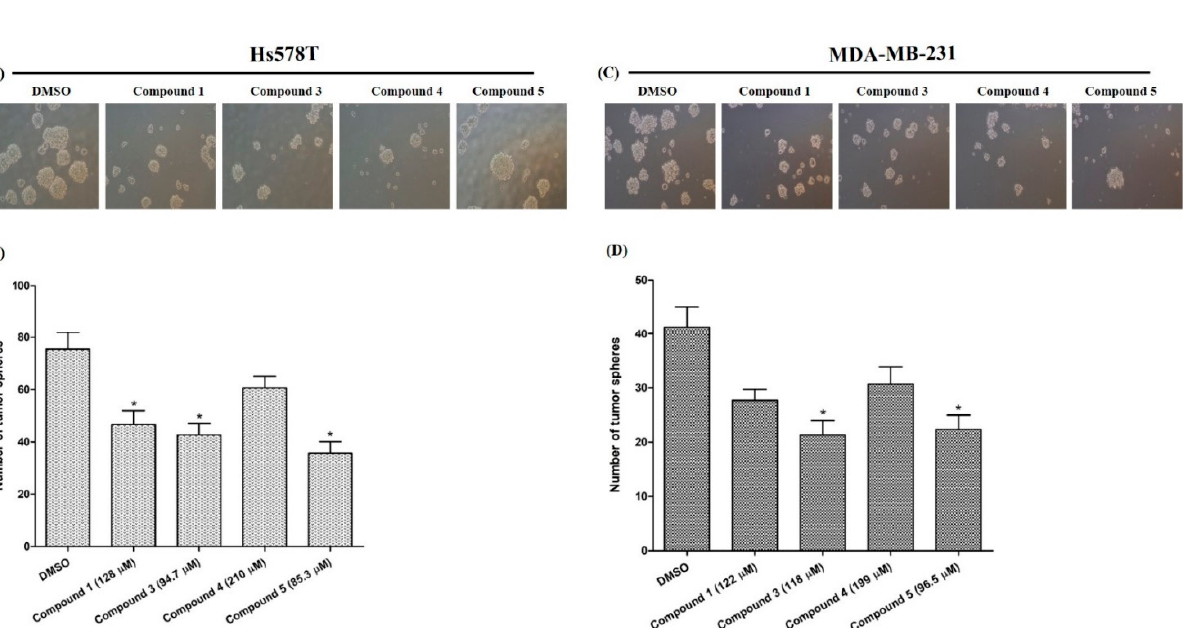
Figure 4. Attenuation of TNBC cell migration. ( A ) and ( C ): visualized migrated cells after treating with compounds. ( B ) and ( D ): the migrated cells stained with crystal violet, and photographs taken for the inhibition calculation. The results are presented as the mean ± SD of three independent experiments. Bars with asterisks indicate significant differences from the control at p ≤ 0.05 (*) or p ≤ 0.01 (**).